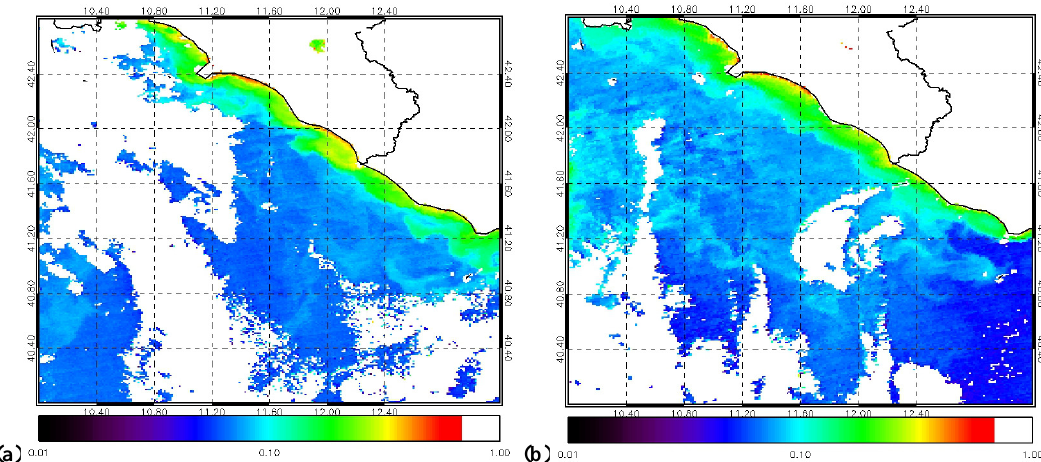
(b) Fig. 6a. 12 January 2010, map of K490 ; units ( m − 1 ), logarithmic scale. Fig. 5. (a) 12 January 2010, salinity at − 5m . (b) 12 January 2010, map of pollutant dispersion; units (gm − 2 ), logarithmic scale. Fig. 5a. 12 January 2010, salinity at –5 m . Fig. 5b. 12 January 2010, map of pollutant dispersion; units ( gm − 2 ), logarithmic scale. 30